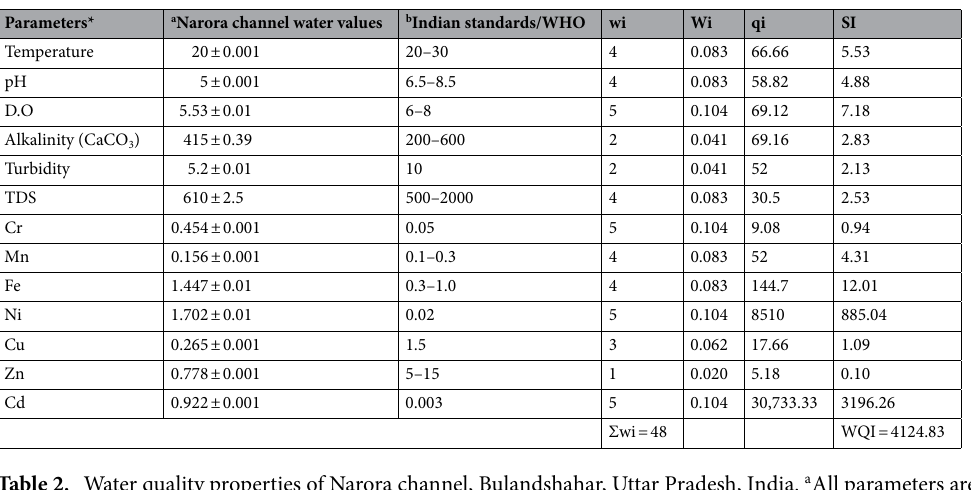
Table 2. Water quality properties of Narora channel, Bulandshahar, Uttar Pradesh, India. a All parameters are presented as mean ± SEM (n = 3). b Range of limits where value limit shows desirable standard. *Temperature was measured in °C and turbidity in NTU whereas D.O, alkalinity, TDS, and all metals in